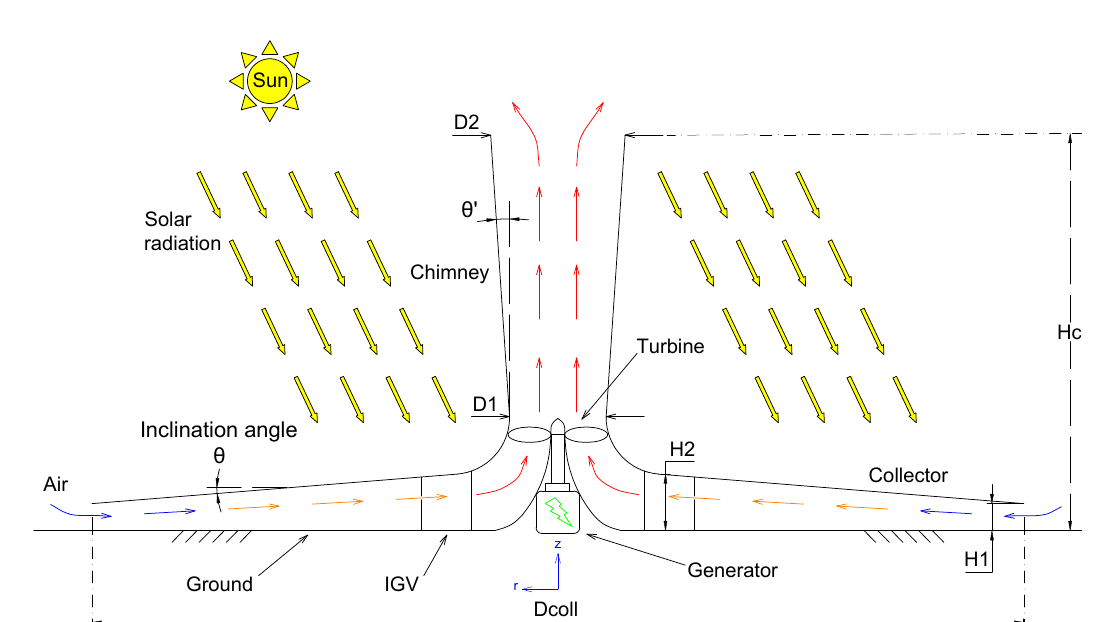
Figure 1. Sectional view of a solar chimney power plant (SCPP) with an axial turbine in the chimney, adapted from [6]. The dimensions are: D 1 = D 2 = 10 m, H 1 = H 2 = 1.85 m, and H C = 194.6